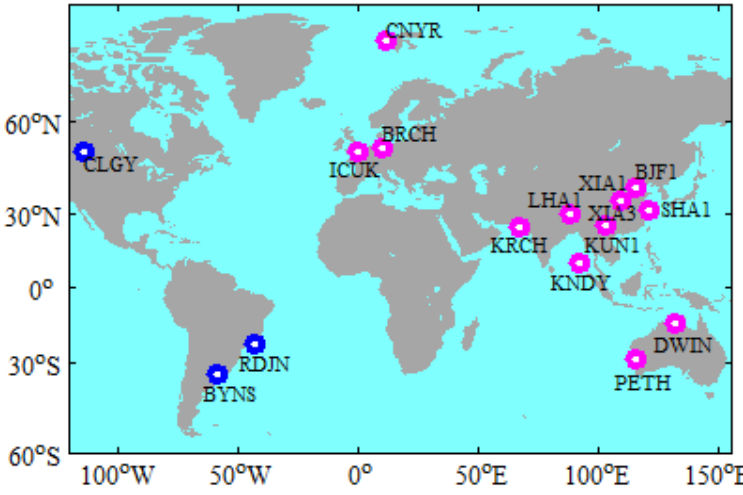
Figure 1. Geographical distribution of the selected stations.